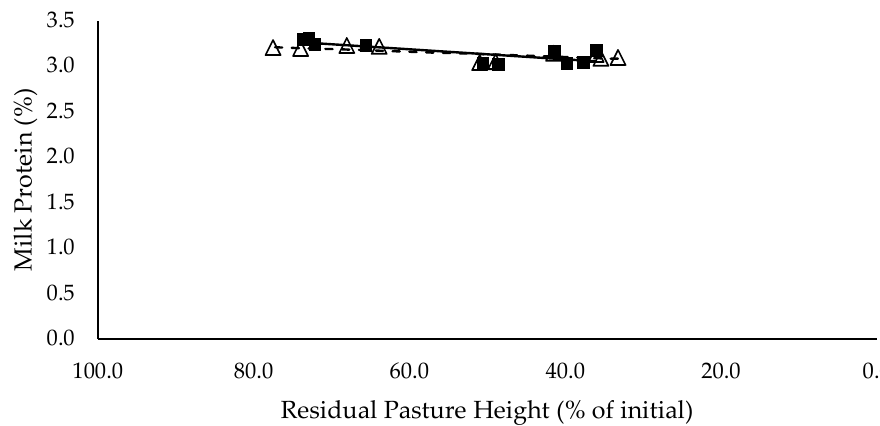
Figure 10. The relationship between milk protein (%) and residual pasture height (% of initial) for